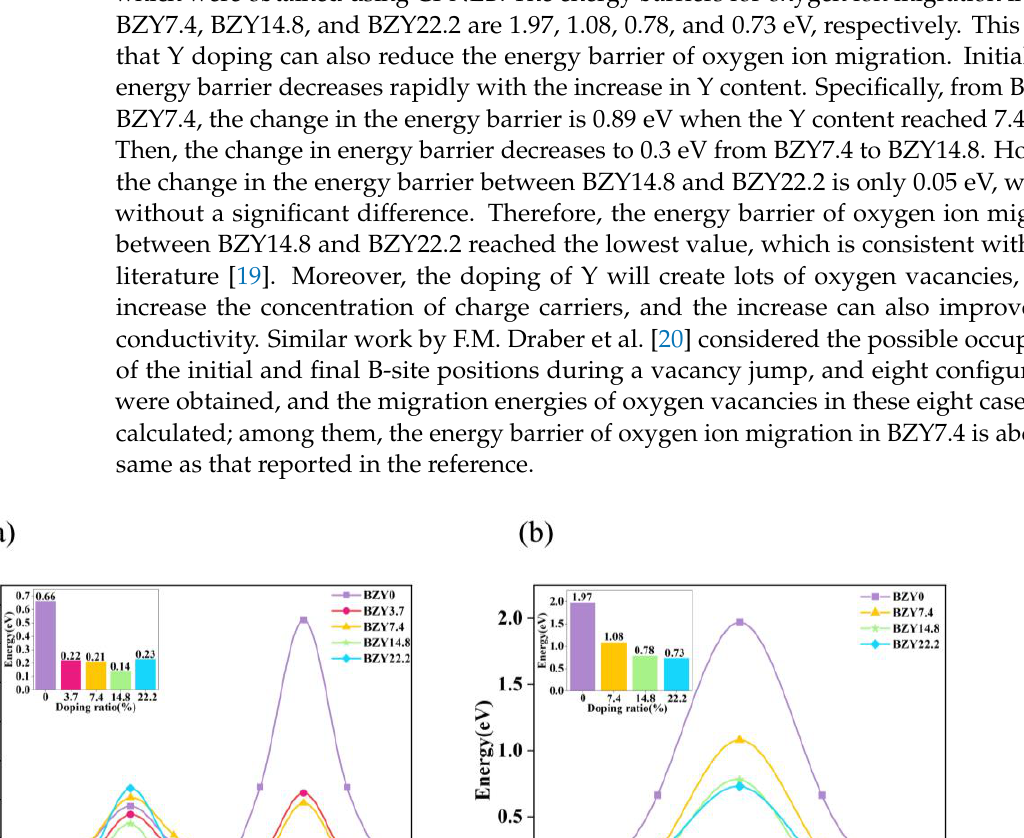
Figure 8. Energy curves of ( a ) proton and ( b ) oxygen ion migration in BZYs.